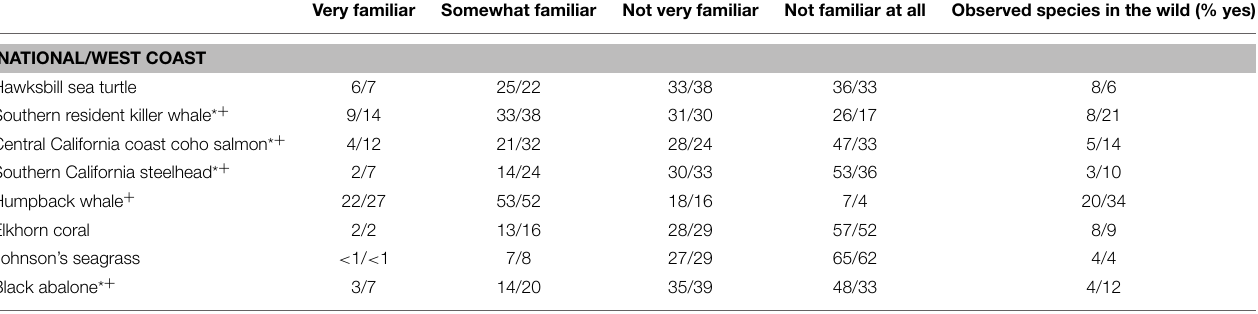
TABLE 3 | Percent of respondents familiar with species.